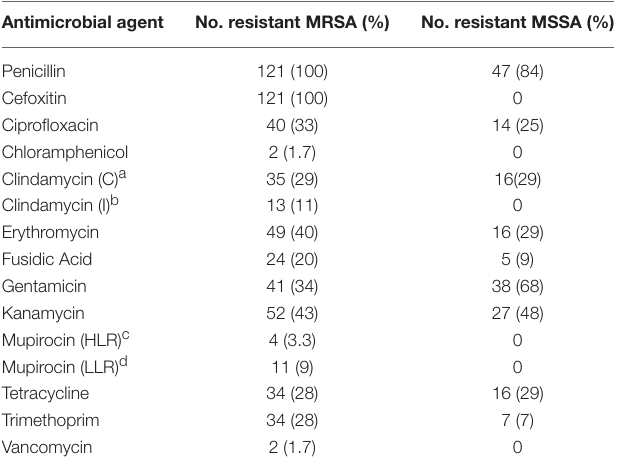
TABLE 3 | Percentage of resistance to each antimicrobial agent